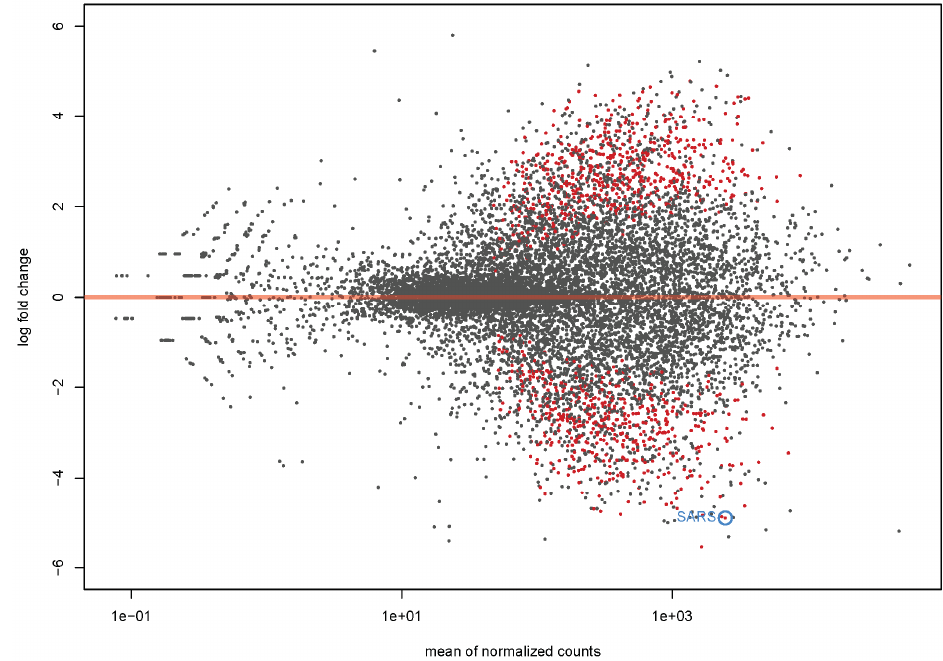
Figure 5. MAplot. The log2 fold changes attributable to a given variable are shown over the mean of normalized counts for all the samples in the dataset. Points that are colored red differ significantly with the adjusted p -value less than 0.1.